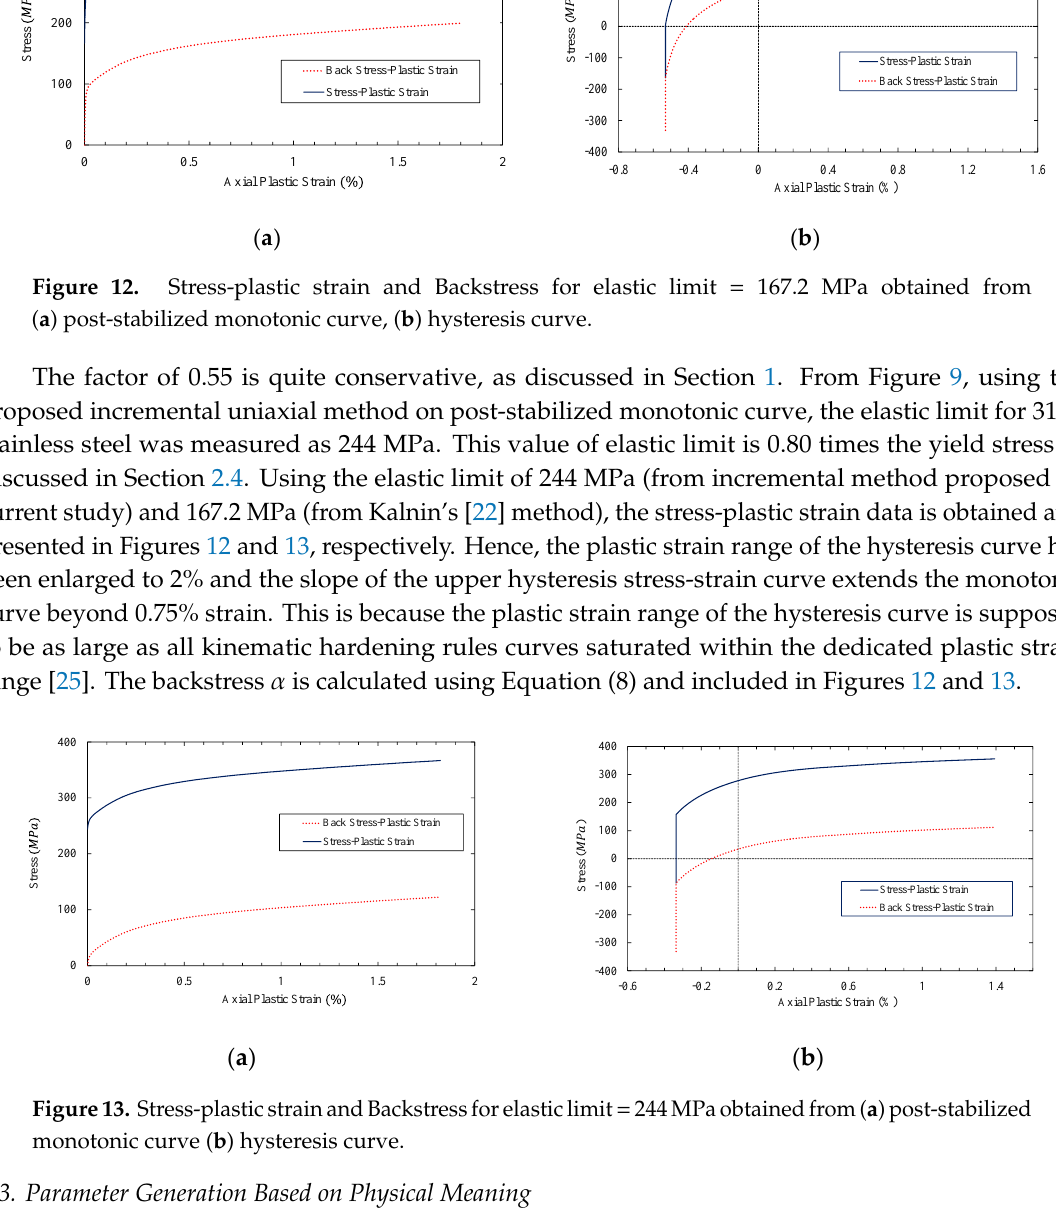
Figure13. Stress-plasticstrainandBackstressforelasticlimit = 244MPaobtainedfrom( a )post-stabilized Figure 13. Stress-plastic strain and Backstress for elastic limit = 244 MPa obtained from ( a ) monotonic curve ( b ) hysteresis post-stabilized monotonic curve ( b ) hysteresis curve.